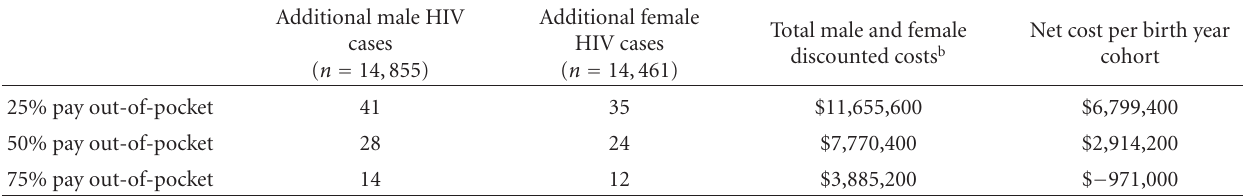
Table 6: Projected additional cases of HIV and additional direct medical costs by percentage of parents electing to pay out of pocket for circumcision a .